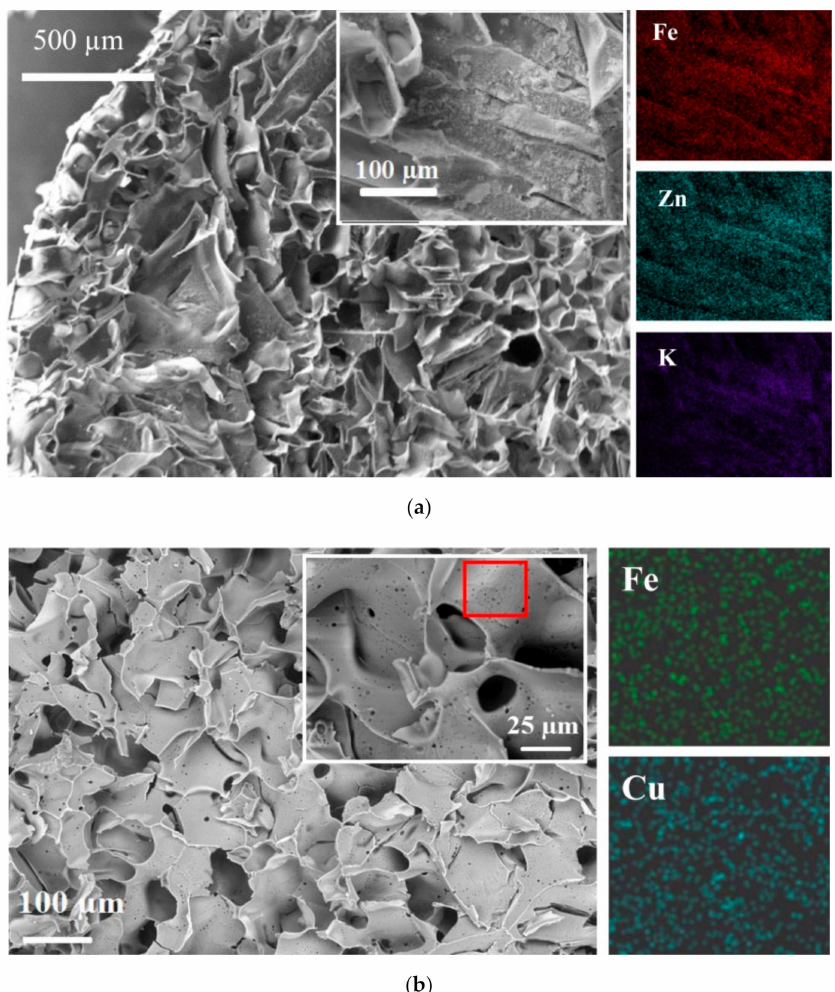
Figure 2. SEM images and EDX mapping for composite PEI cryogel containing Zn(II) ferrocyanide